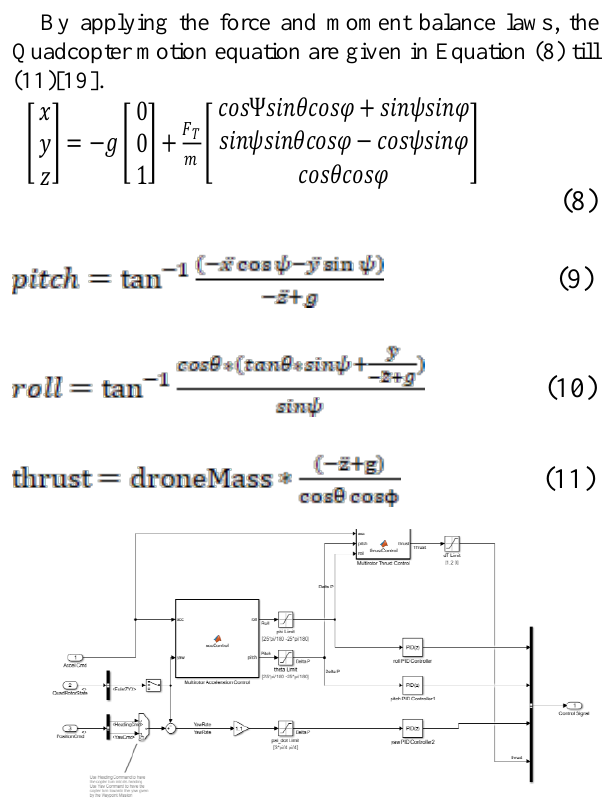
Figure 9. Altitude control design strategy